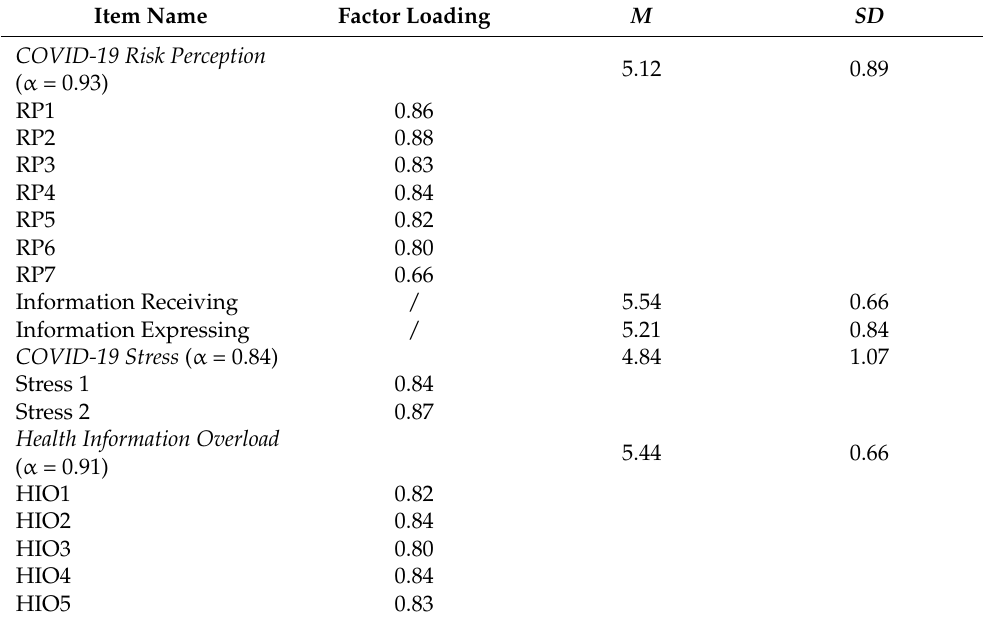
Table 2. Confirmatory factor analysis results of measured variables (N =